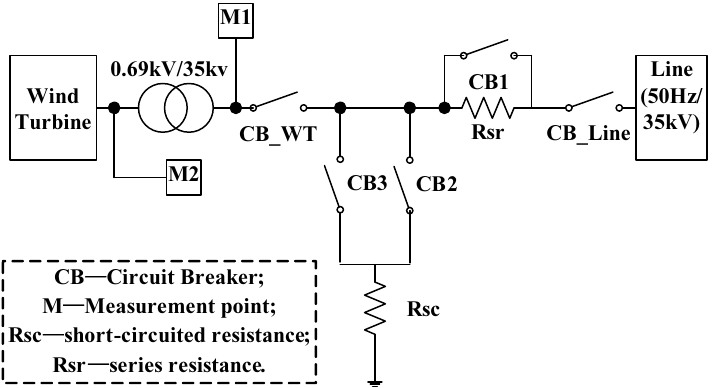
Figure 19. The method of the ZVRT field